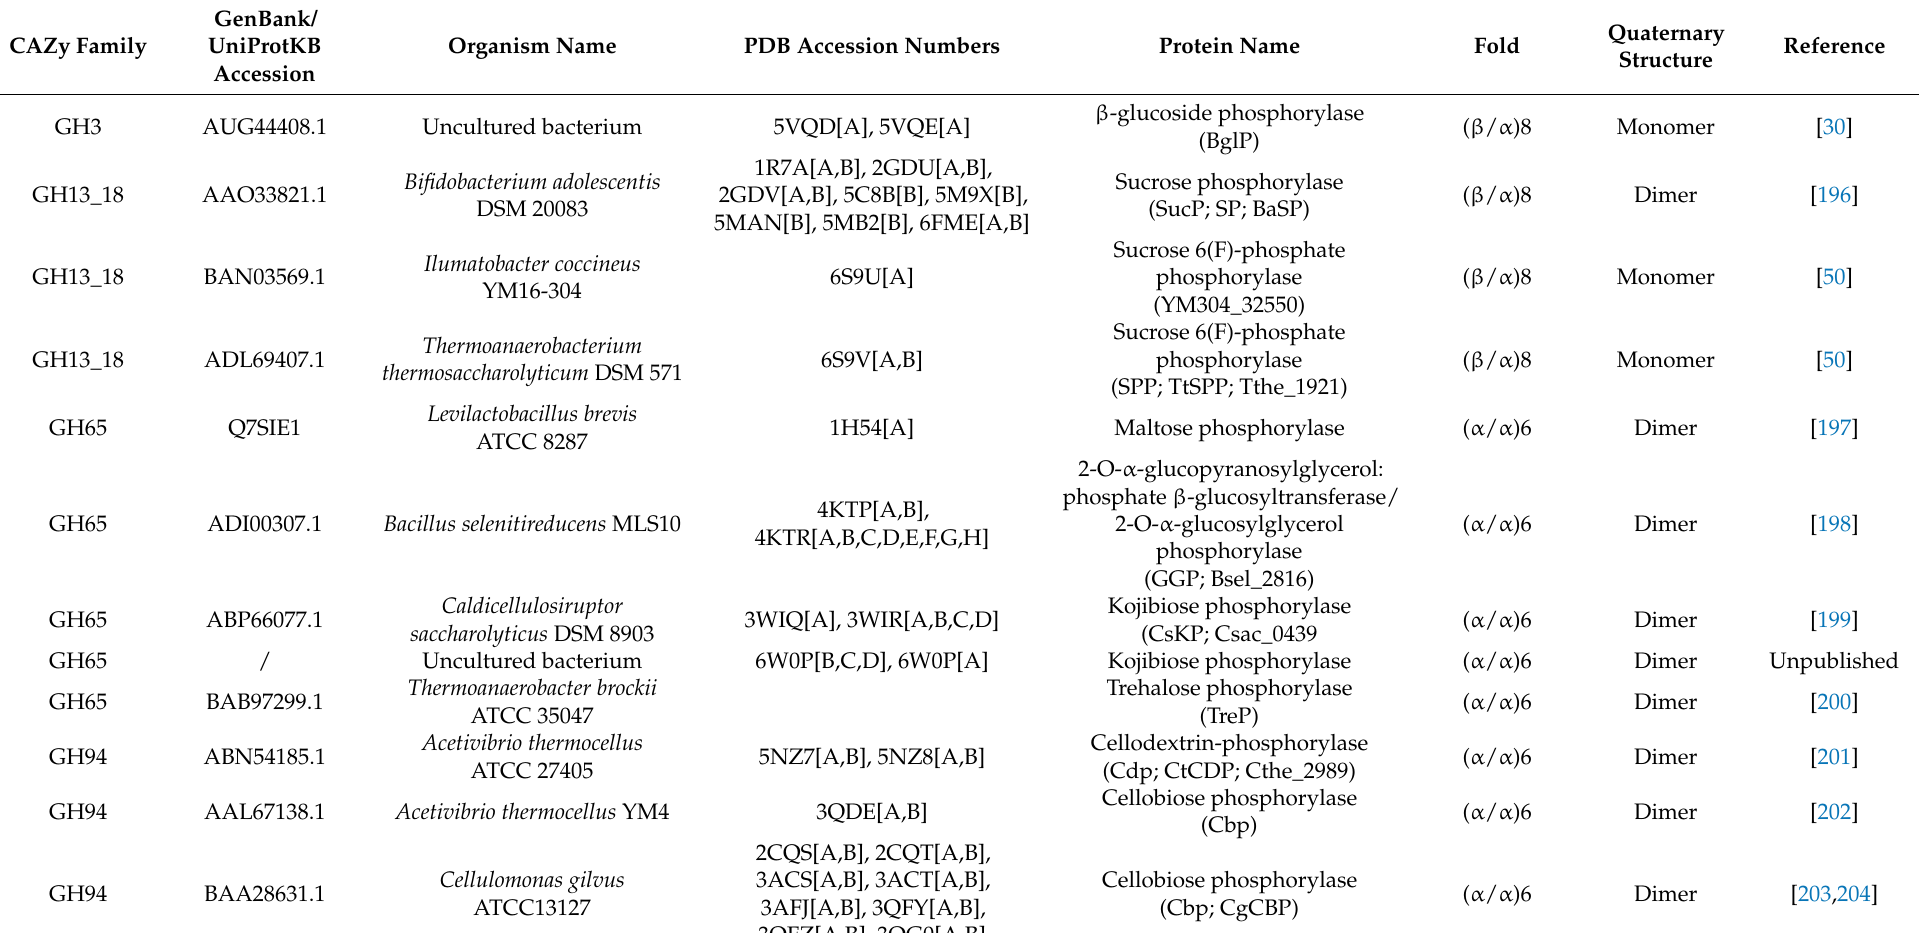
Table 2. Structurally characterized GPs. Only the enzymes proven to have GP activity are listed. ACJ76617.1 has dozens of PDBs, only the PDB with the best solution is